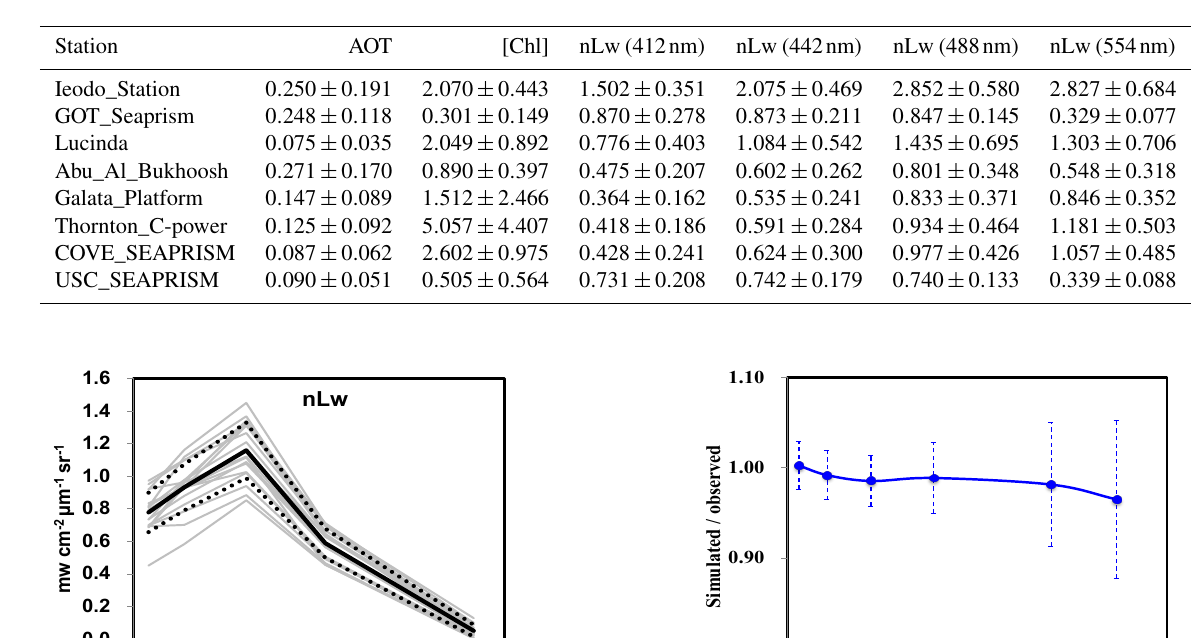
Table 3. Mean values and the SD of in situ AOT at 550nm, Chl (mgm − 3 ) and nL w (mwsr − 1 cm − 2 µm − 1 ) at selected stations.